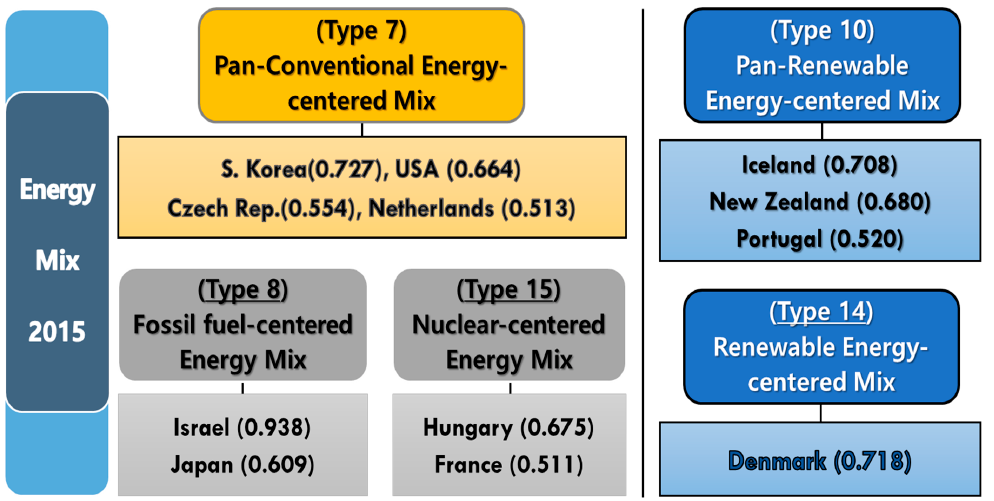
Figure 1. The main results of Energy Mix 2015.